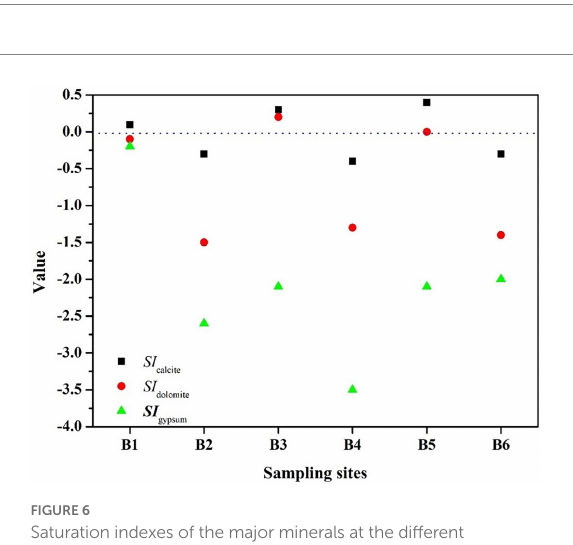
FIGURE 6 Saturation indexes of the major minerals at the different boreholes. The relative abundance of S. kujiense among the different wells roughly matched the HCO 3 − concentrations (Figure 5), especially in B2 and B6 (Figure